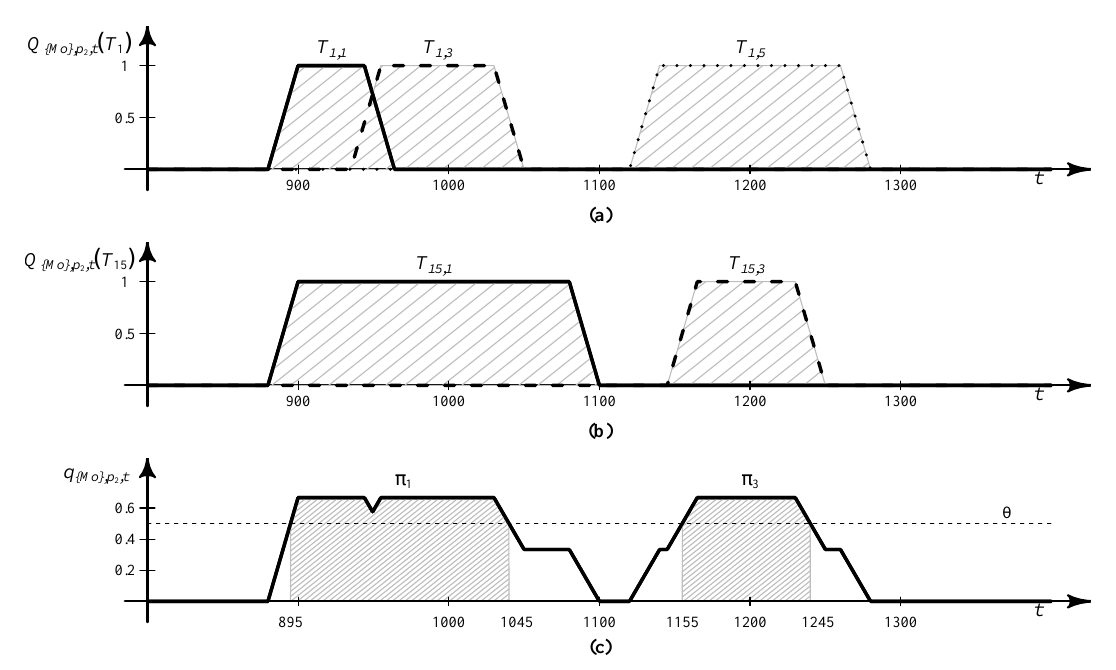
( T ) ; ( b ) Q ( T ) ; and { Mo } , p 2 , t 1 15 2 , t